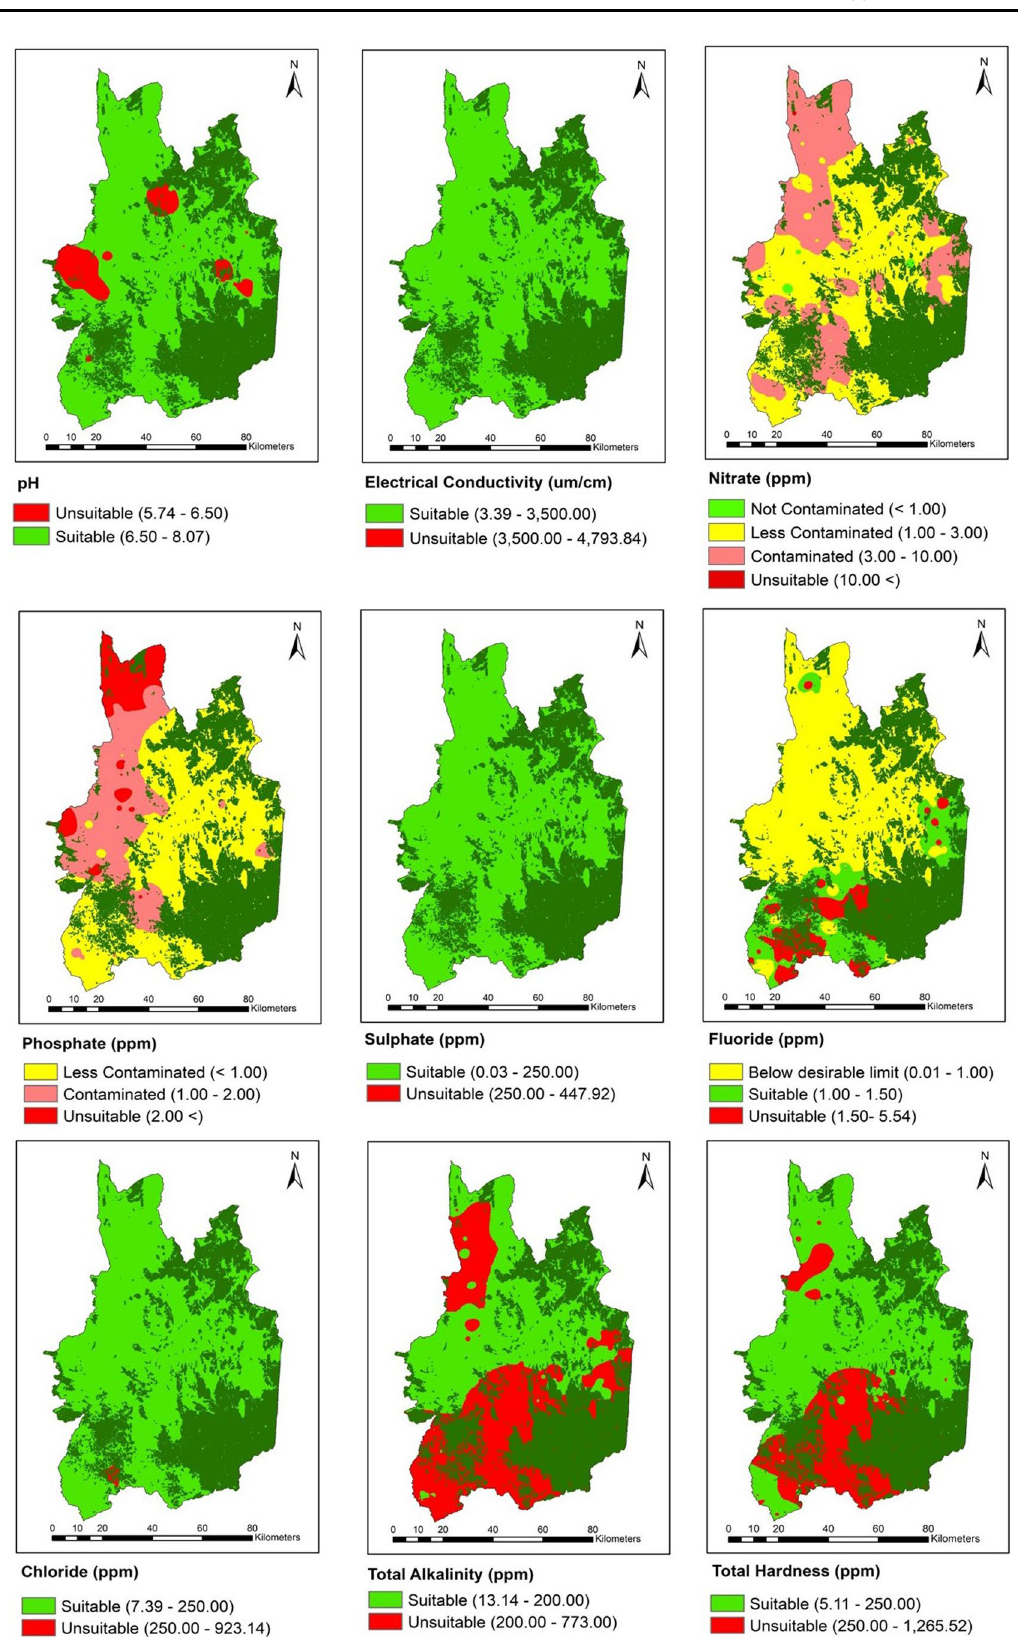
Fig. 4 Maps show spatial distribution of groundwater quality parameters (pH, EC, NO 3− N, PO 43− , SO 42− , F − , Cl − , HCO 3− , hardness) in the